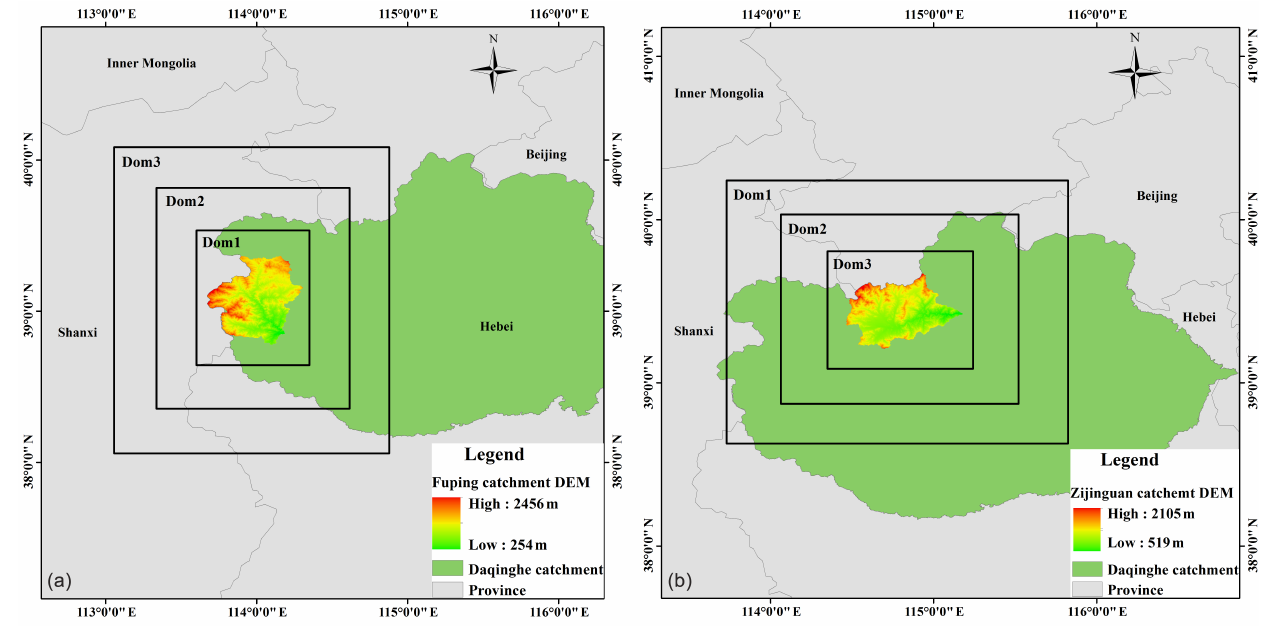
Figure 1. The nested domains and the orography of the Fuping catchment and Zijingguan